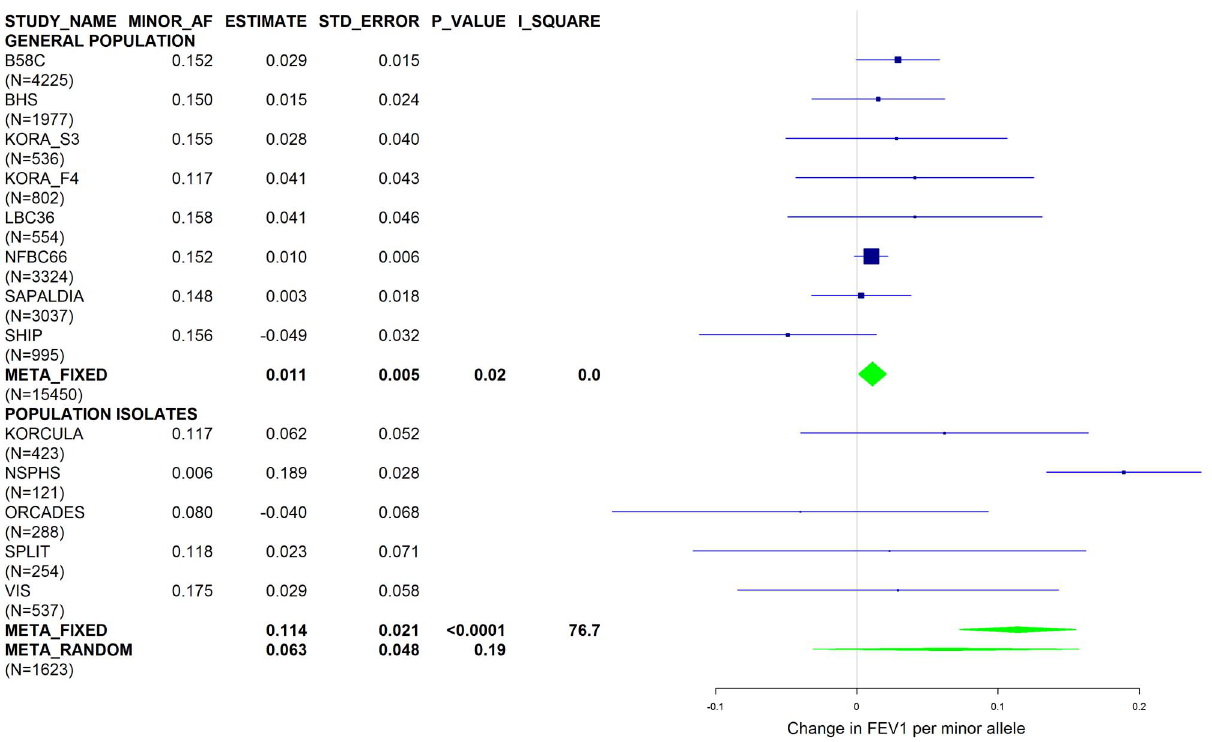
Figure 7. Forest plot of meta-analyzed results for the effect per minor allele of rs3748312 on FEV1 in ever-smokers, adjusted for sex, age, height and population stratification factors. Studies based on population isolates with a high degree of cryptic relatedness are presented separately. Effect estimates of meta-analyses are shown with green diamonds. I 2 is a measure of the heterogeneity between studies. Random effect meta-analyses are included if I 2 . 0.5. Study weights (blue squares) correspond to fixed effect meta-analyses.